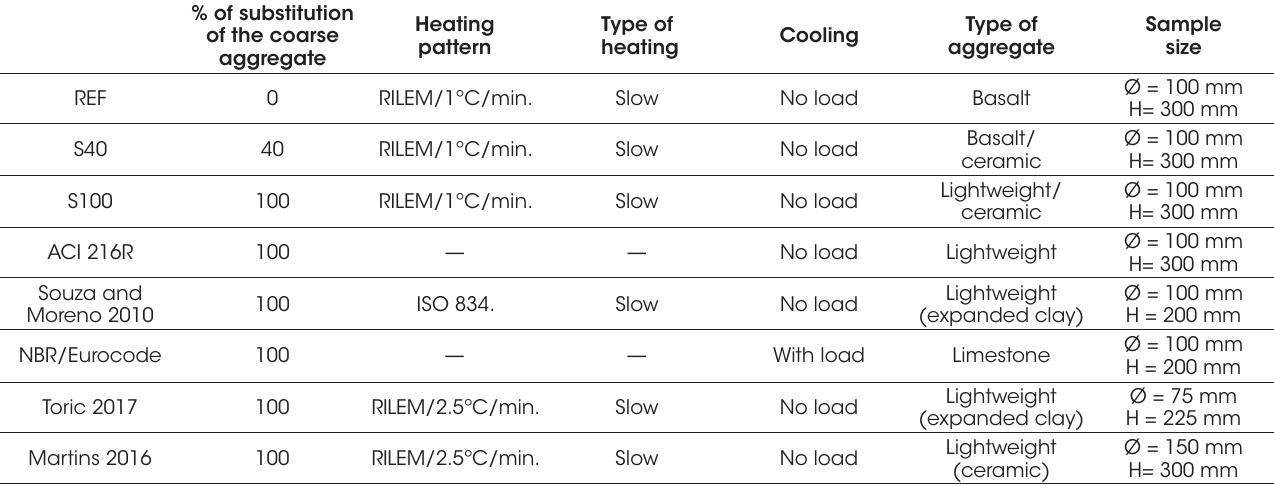
Comparative data of the test parameters (residual strength) % of substitution of the coarse